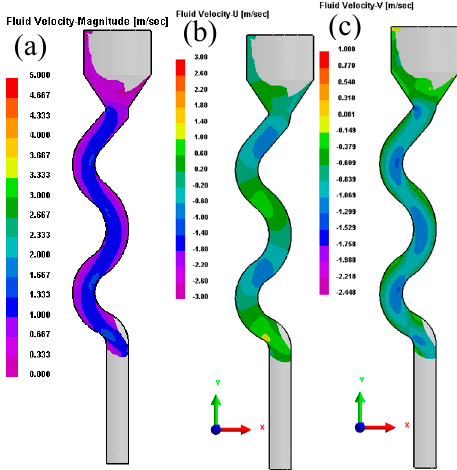
Figure 7. 7075 aluminum alloy melt flow process in a triple-bend serpentuator: ( a ) total velocity field, ( b ) velocity field in the X-direction, and ( c ) velocity field in the Y-direction.